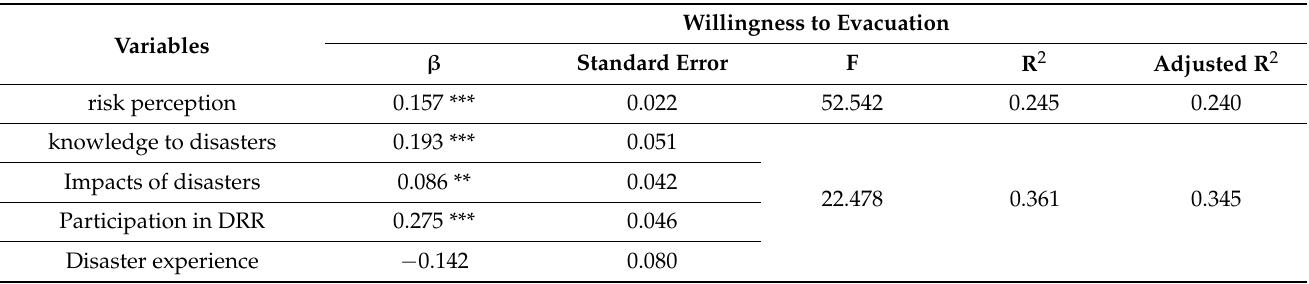
Table 3. Regression analysis between risk perception and willingness to